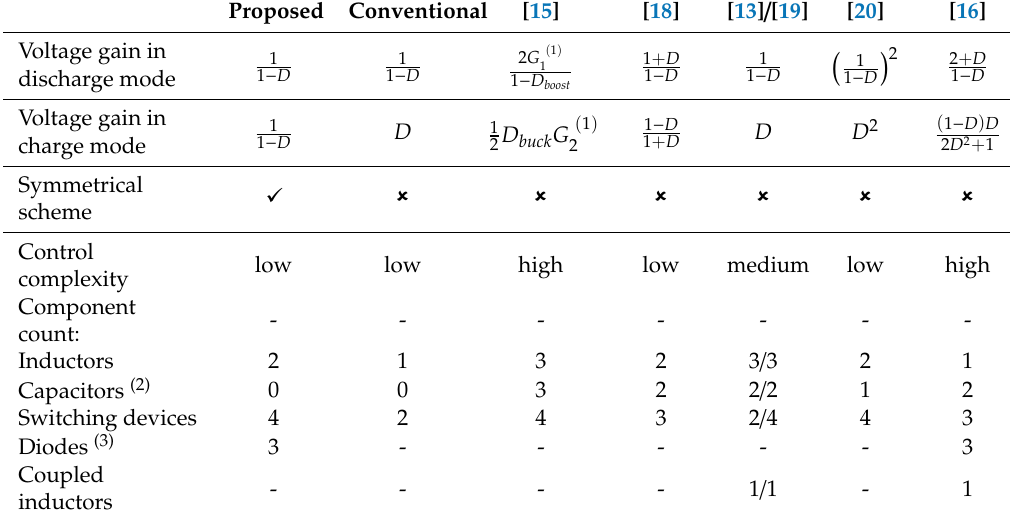
Figure 2. Proposed bidirectional DC-DC converter.